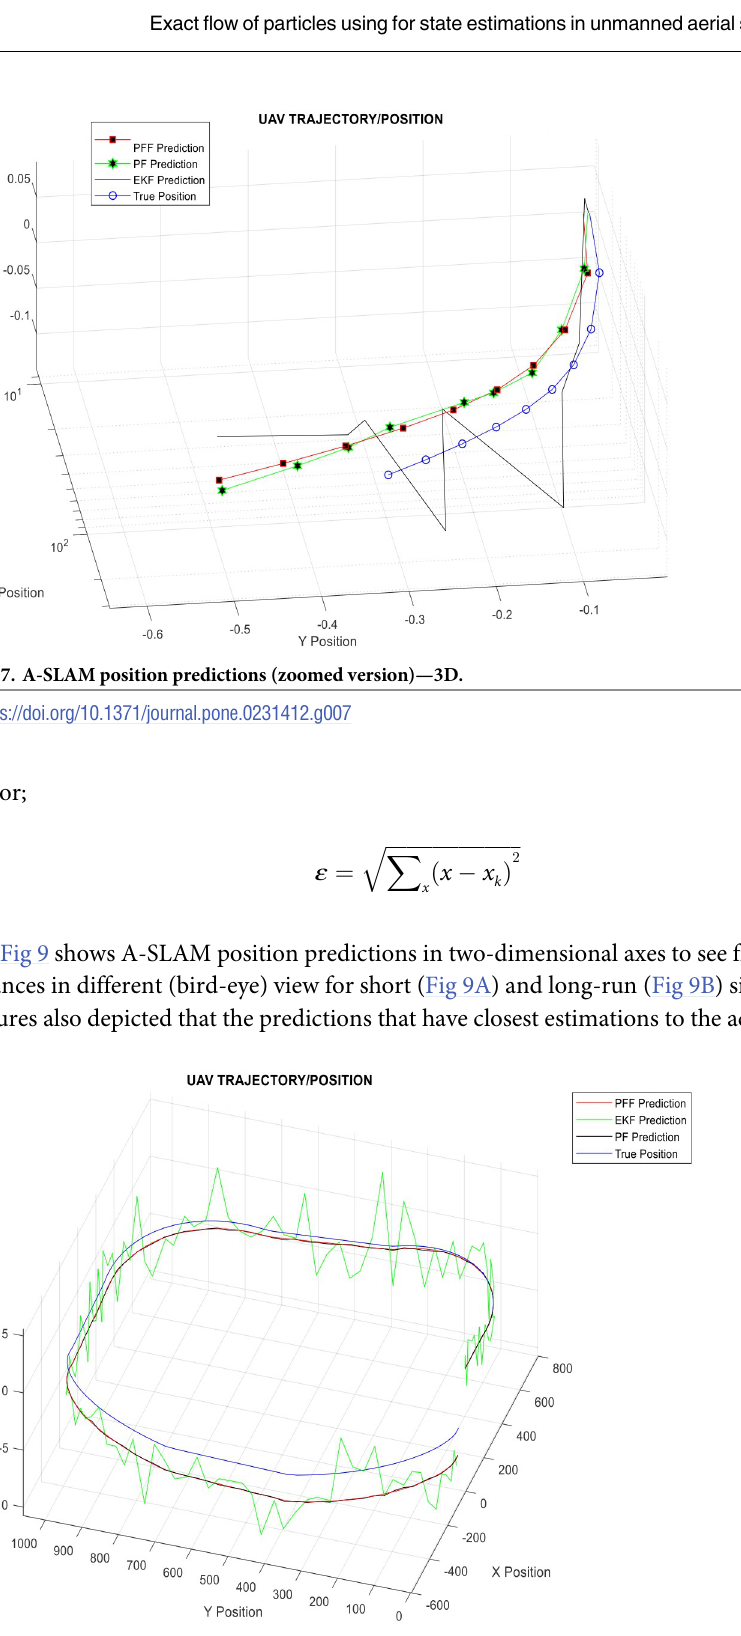
Fig 8. A-SLAM position